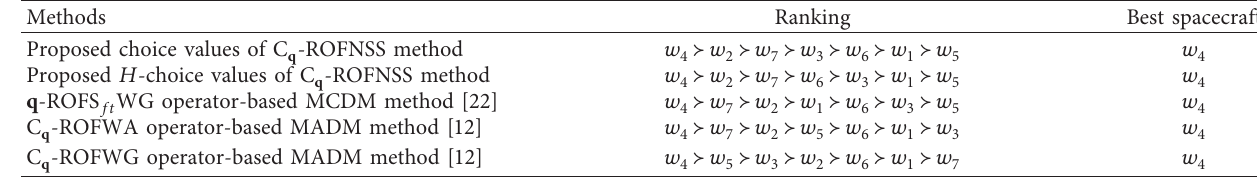
Table 28: Comparative